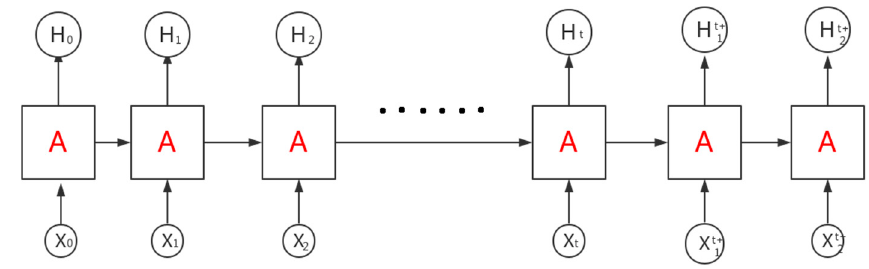
Figure 9. LSTM Figure 9. LSTM structure. Figure 9. LSTM structure.